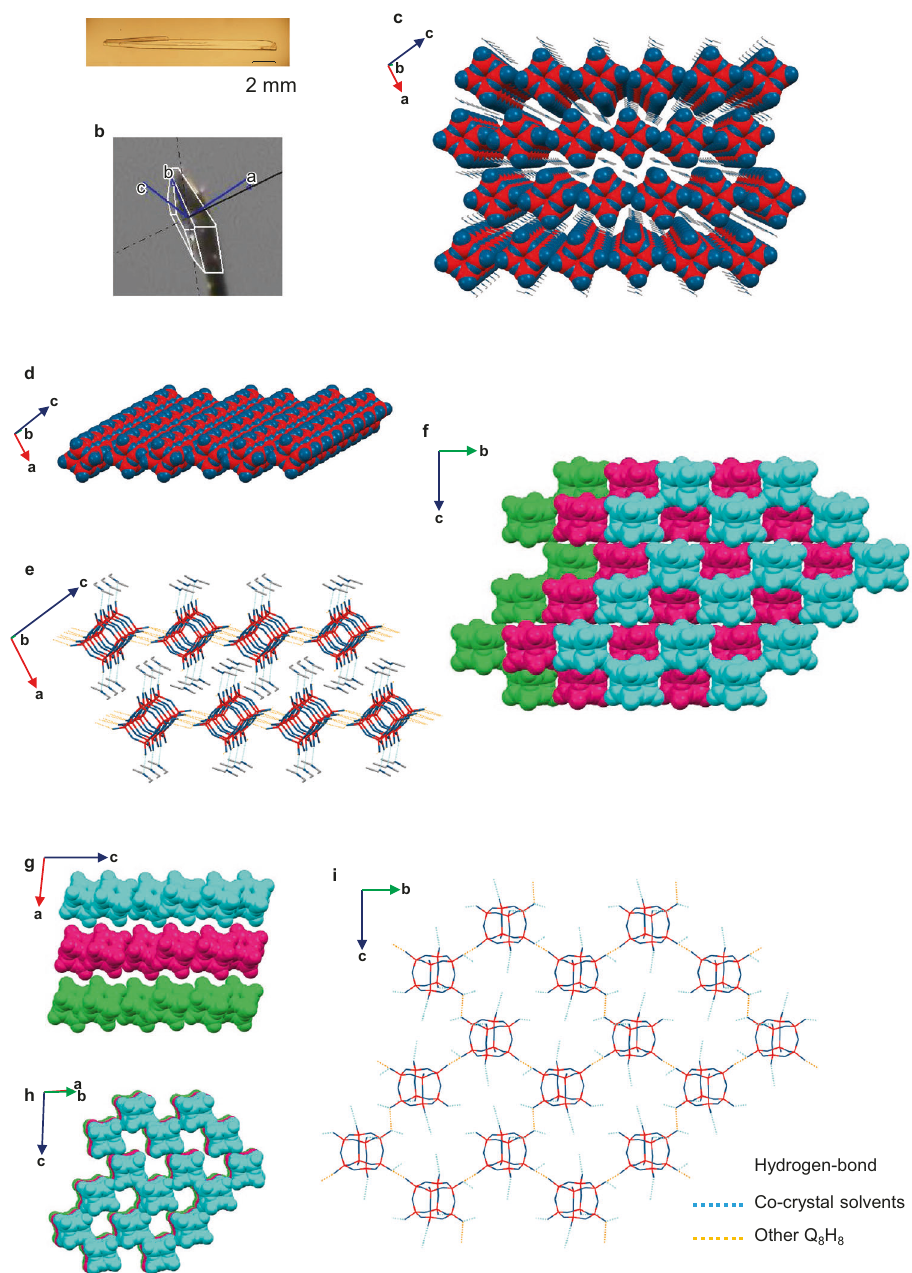
Fig. 2 Crystal structures of 2D crystals. Crystal structures of 2D-S ( a – e ), and 2D-MS ( f – i ) determined by single-crystal X-ray diffraction. The hydrogen atoms have been omitted for clarity (Si: red; O: blue; C: gray; hydrogen bonds between Q 8 H 8 : orange dashed lines; hydrogen bonds between Q 8 H 8 and co- crystallization solvents: light blue dashed lines). a Polarized micrograph; b crystal photograph with cell axes, which were drawn by CrysAlisPro software; c crystal packing; d 3D space- fi lling representation of HIF ’ s network; e , i hydrogen-bonding interactions; f top, g side, and h oblique space- fi lling views of three layers of the stacked mesh sheets of 2D-MS (co-solvent molecules omitted for clarity), in which the fi rst, second, and third layers are colored light blue, pink, and green,